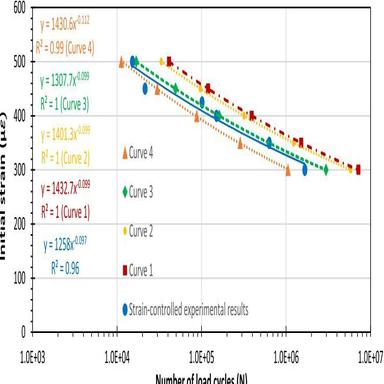
Comparison of simulated and experimental results: strain-controlled fatigue tests .